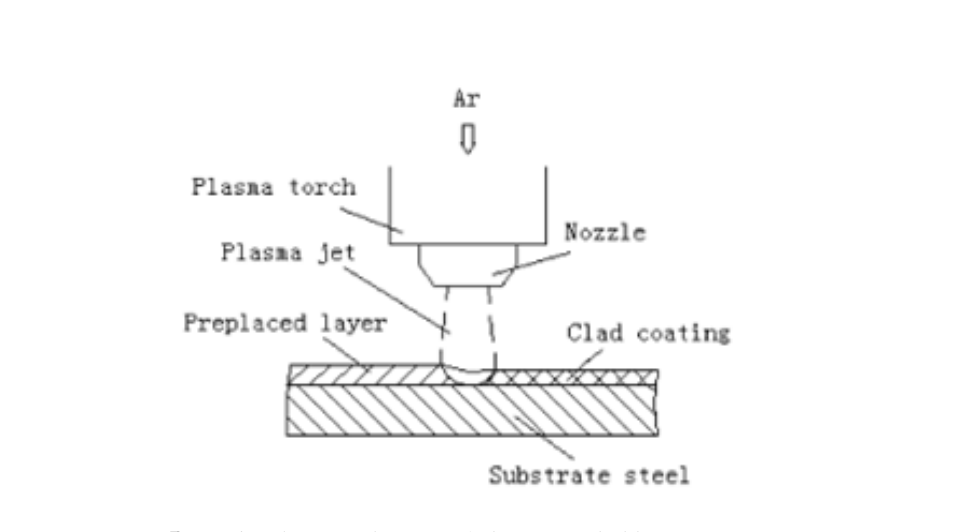
Figure 2: Schematic diagram of plasma arc cladding